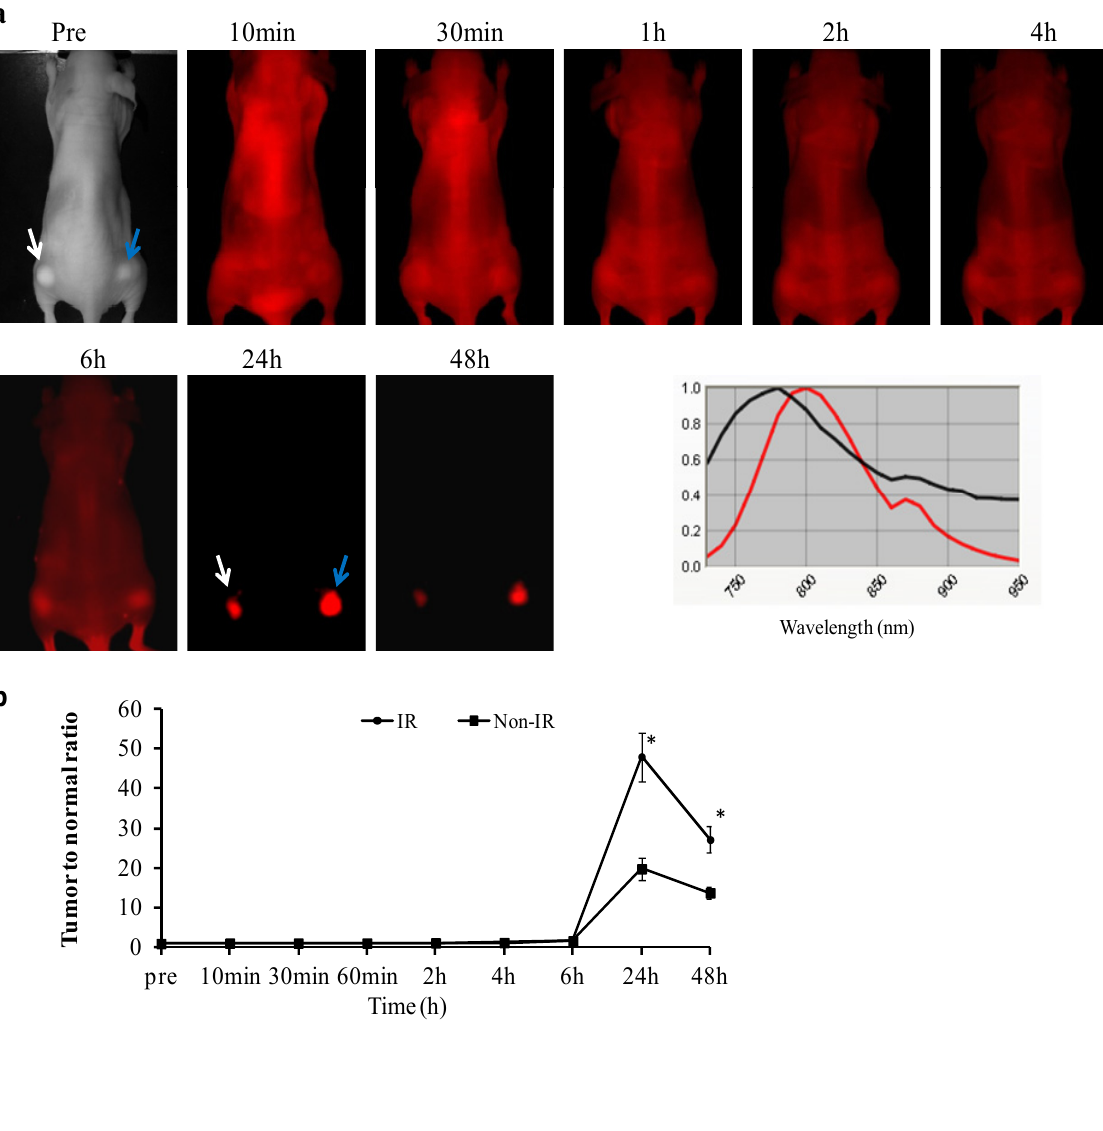
Figure 3. In vivo longitudinal NIR imaging of exposed PS in gliomas with/without radiation. ( a ) A mouse bearing representative size-matched subcutaneous U87 tumors (arrows) on each thigh received 12 Gy of irradiation to the right side tumor (blue arrow). Twenty-four hours after radiation, PGN-L-800CW (1.8 nmol/mouse) was injected via a tail vein and a series of in vivo fluorescence images was acquired at different time points. There were significant normal tissues signals during the first 6 h post injection, indicating that the nanoprobes were remaining in blood circulation. However, the optical signals were only detected from the tumors at 24 h, which sustained at least to 48 h post injection. Representative in vivo emission wavelengths of the PGN-L-800CW (red) and normal tissue fluorescence (black) were presented ( b ) Time course curves of TNR revealed a maximal TNR = 20 ± 3 at 24 h for the non-irradiated tumors ( n = 6). Irradiation of the tumors ( n = 6) increased levels of exposed PS to a TNR of 48 ± 6 ( * p < 0.05 from